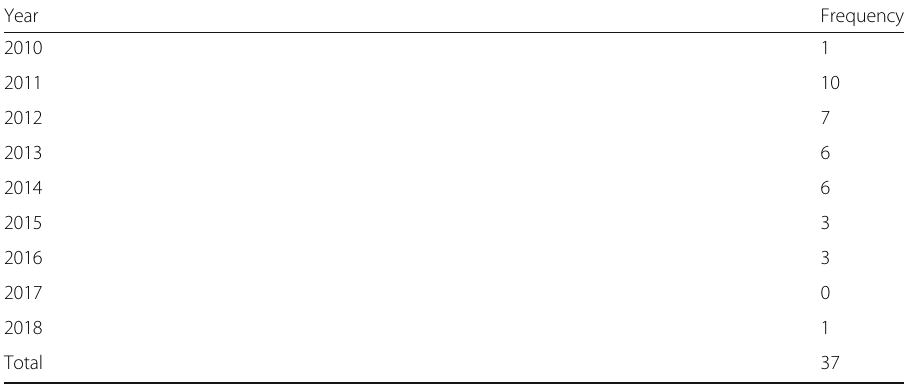
Table 1 Number of sources listed by